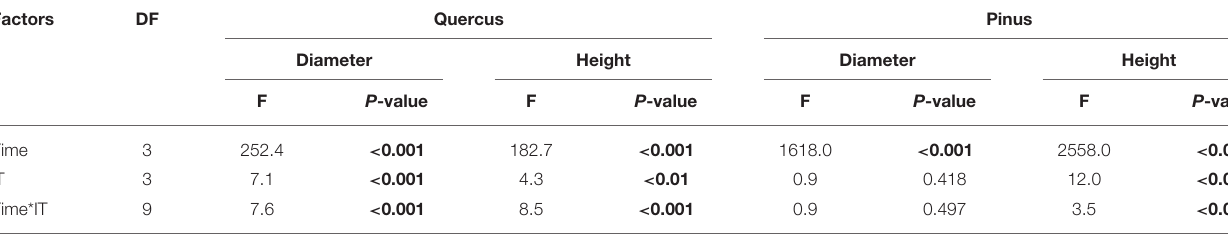
TABLE 1 | Temporal effects of interference treatments on growth traits of Pinus and Quercus . Factors